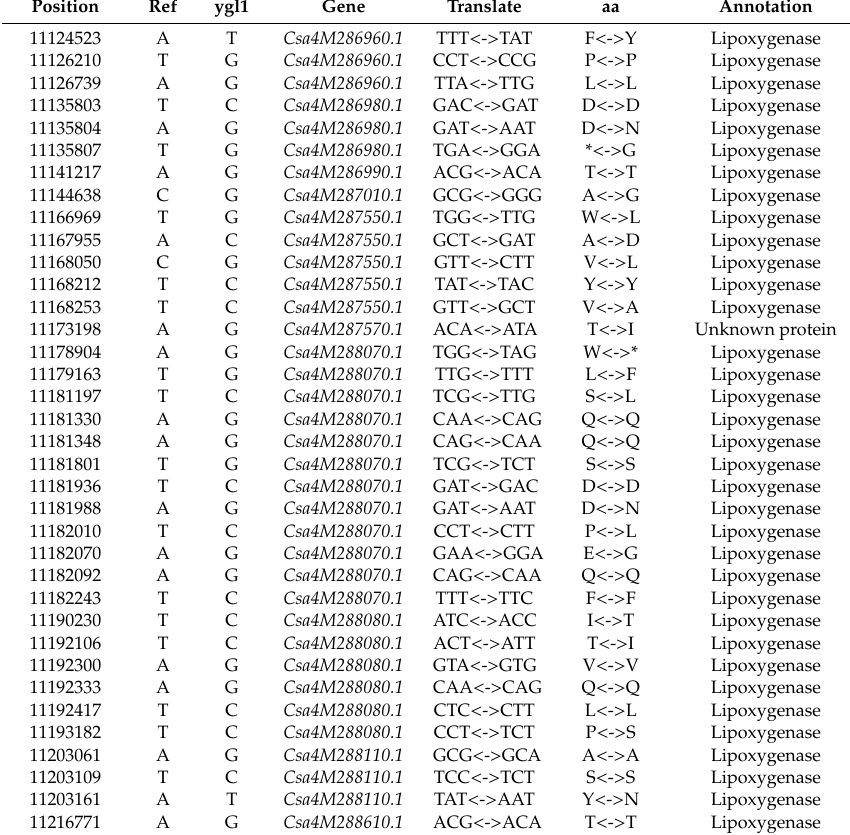
Table 2. Single nucleotide polymorphisms (SNPs) distribution in the region of 10 predicted LOX genes present in tandem in the cucumber genome chromosome